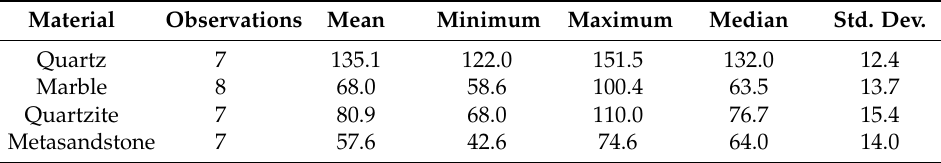
Table 3. The statistical results of uniaxial compressive strength ( UCS) (MPa).